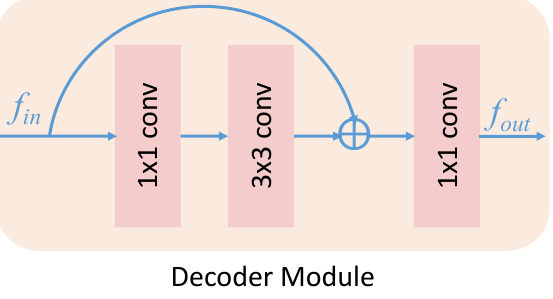
Figure 3. The architecture of the decoder module.